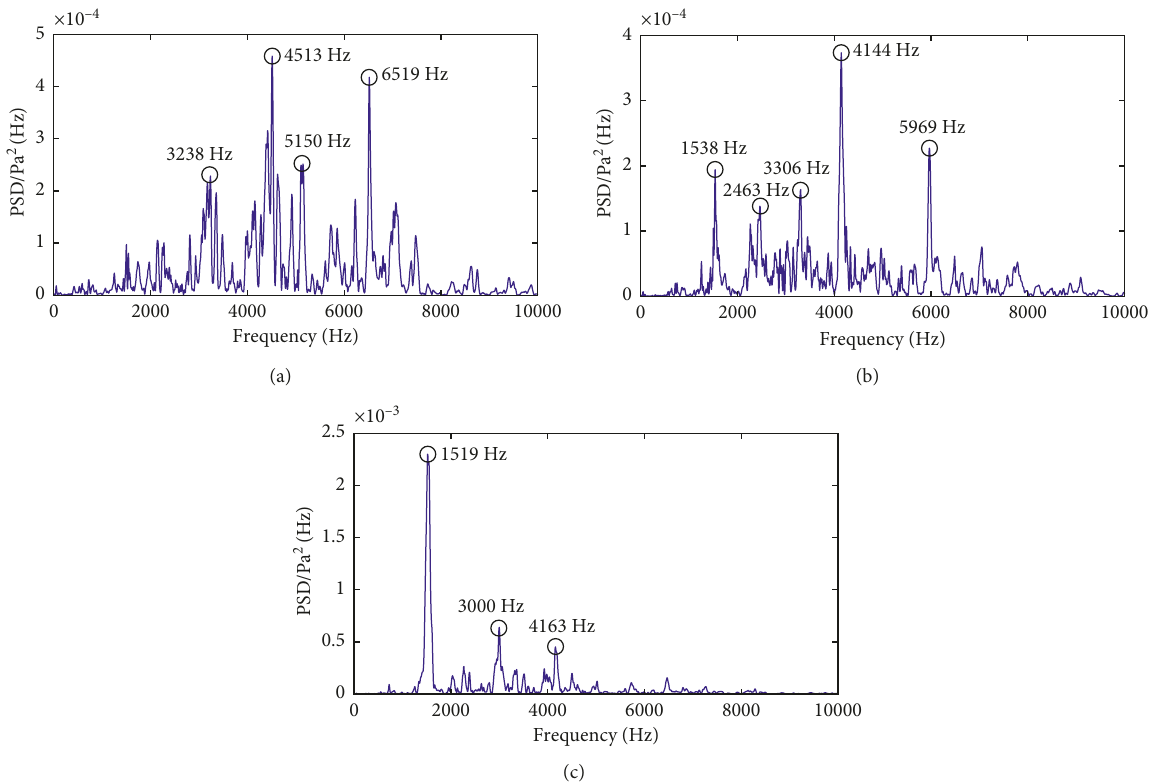
Figure 9: The PSD of each side pulse sound pressure. (a) Main slap side sound pressure PSD, (b) cylinder head top sound pressure PSD, and (c) vice slap side sound pressure